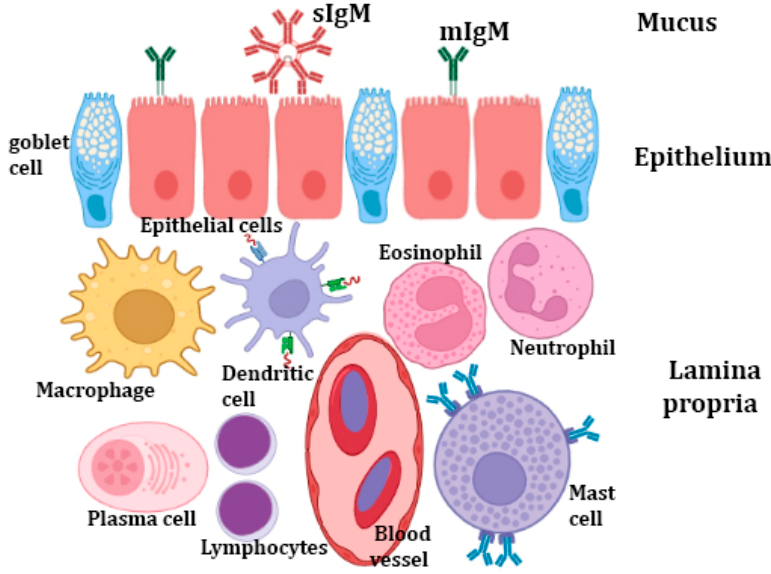
Figure 1. Schematic representation of the fish mucosal immunity.